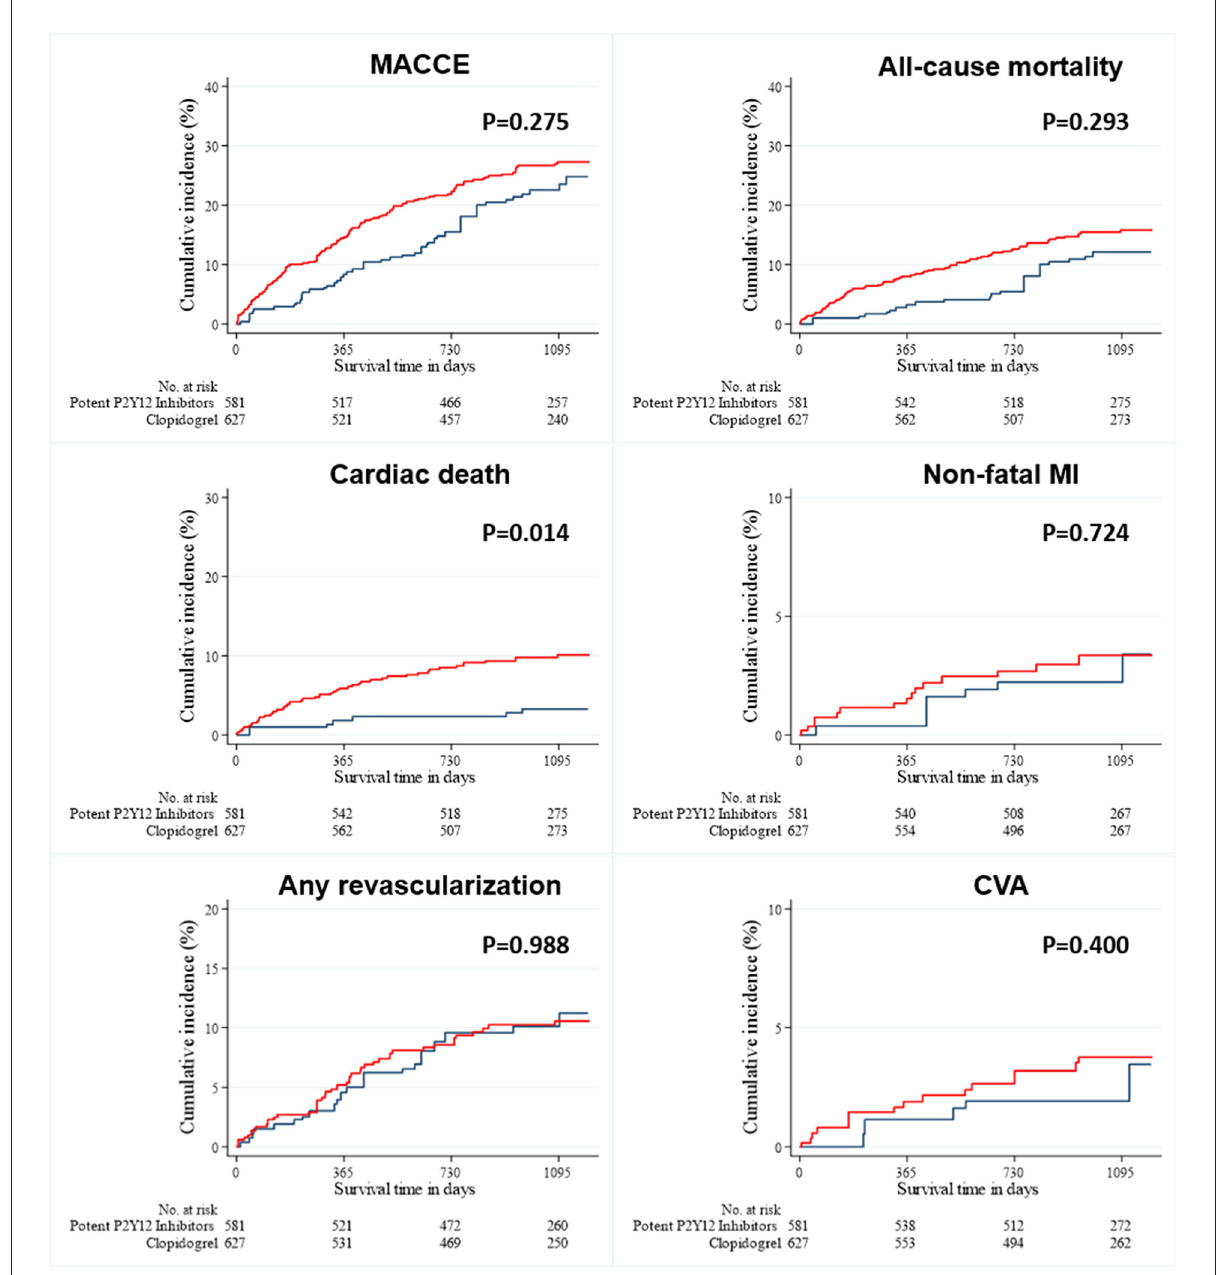
FIGURE4 Event rates of clinical outcomes for all patients after a 3-year follow-up (after IPTW-adjusted analysis). The Kaplan–Meier curves for cumulative event rates according to the type of P2Y12 receptor inhibitors are shown. The red curve indicates group A, and the blue curve indicates group B. CVA, cerebrovascular accident; IPTW, inverse probability of treatment weighting; MACCE, major adverse cardiac and cerebrovascular event; MI, myocardial infarction.